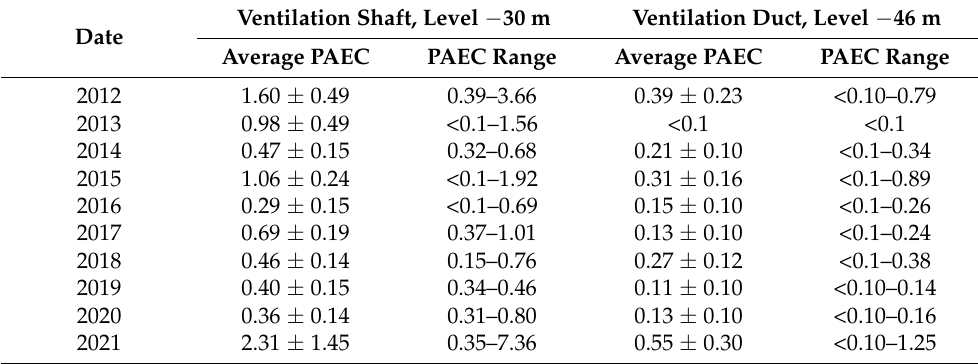
Table 1. Results of PAEC monitoring in the experimental mine—values in µ J · m − 3